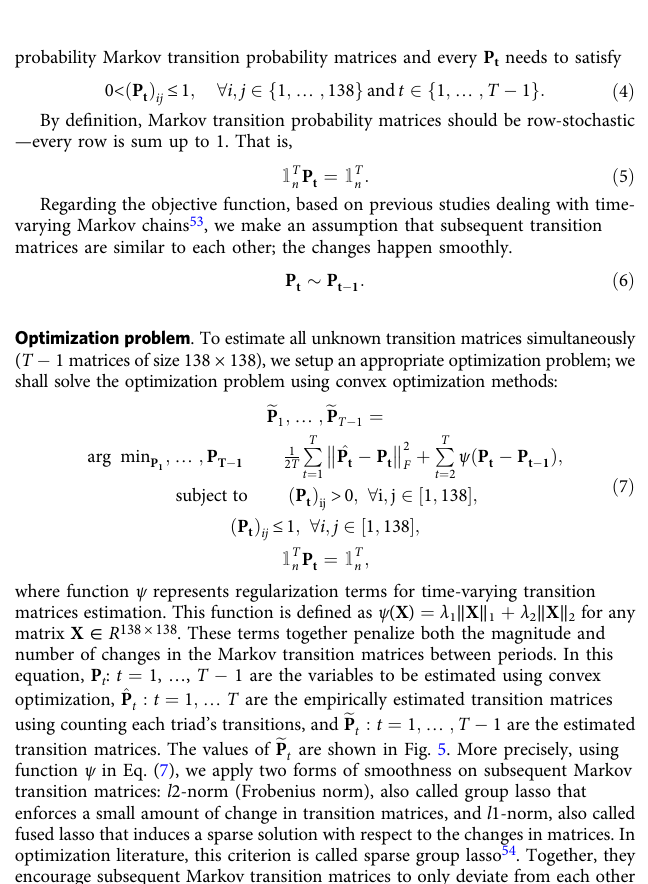
Fig. 5 Probability of kinds of transitions. Estimated transition probability for a transitivity-, b clustering-, and c classical-balanced and -unbalanced triads in Integrated Crisis Early Warning System (ICEWS) dataset (the pipeline is described in Fig. 4). The Y -axis indicates the kind of transition and the X -axis shows the estimated probability (computed by solving Eq. (7)), the box is the interquartile range of the probability distribution, the orange line is the median and green dot is the average of the distribution, and the whisker shows minimum and maximum of the range of the distribution. This fi gure shows that the probability of transitions from unbalanced triads to balanced ones is signi fi cantly higher than the opposite transitions. Also, the probability of remaining balanced is more likely than the probability of remaining unbalanced. These fi ndings hold regardless of the de fi nition of balance. Box plots are computed using n = 103 network snapshots of quarters. Supplementary Fig. 1 extends this analysis to two Bitcoin datasets showing that movement toward balance is not a peculiarity of the ICEWS